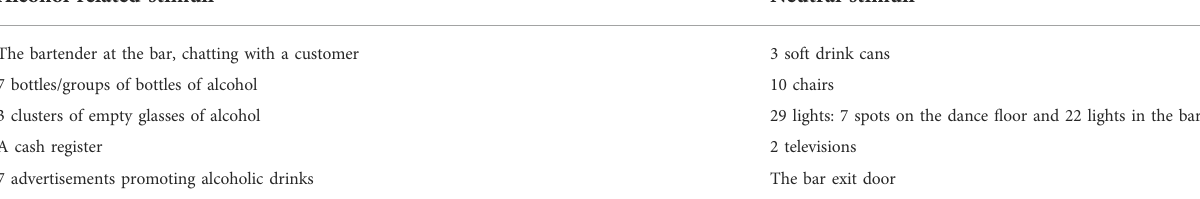
TABLE 2 List of alcohol-related and neutral stimuli. Alcohol-related